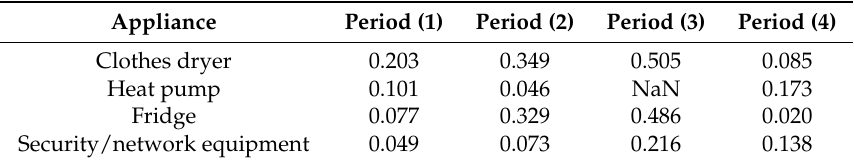
Table 3. PCE (%) values from four periods for the four appliances.